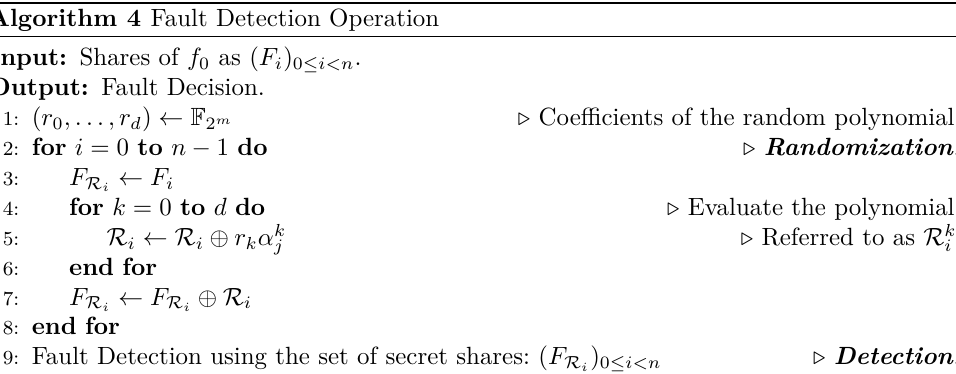
Algorithm 4 Fault Detection